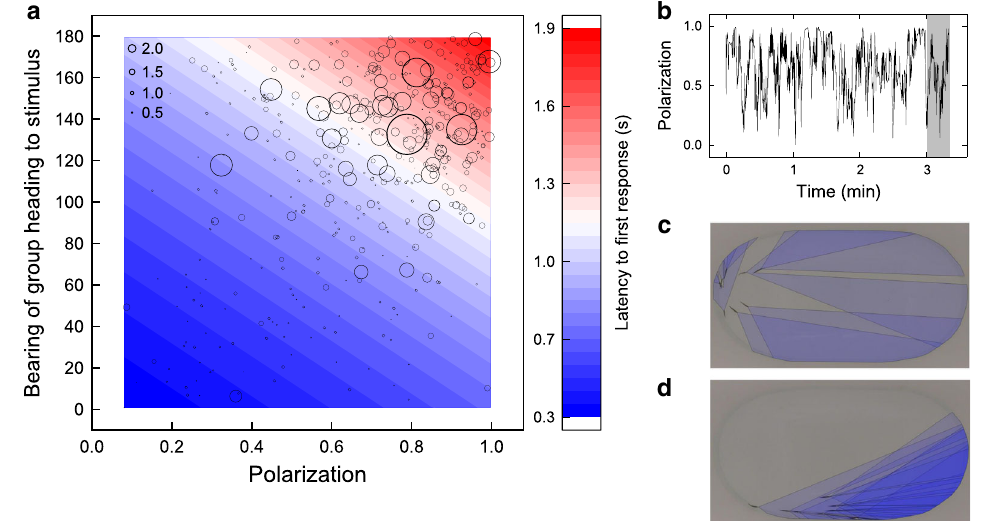
Fig. 2 Variation in collective order affects the latency to fi rst respond to the stimulus. a The effects of group polarization and bearing of the group heading to the stimulus on the latency of fi rst responders to respond to the stimulus. Points represent the raw data with point sizes scaled relative to the latency to respond (seconds, scale bar displayed in the top left-hand corner). The colour gradient (blue to red) represents the predicted response latency (seconds) generated from a negative binomial GLMM with all other group-level parameters held at their mean value. b Example time series of a group ’ s polarization to illustrate temporal variation in collective order. The time series shows the 3 min before (unhighlighted) and 20 s following (highlighted in grey) a single stimulus presentation. c An illustration of the binocular visual range of a disordered group. d An illustration of the binocular visual range of a highly polarized group. In c , d , the blue regions highlight the area of the arena within the binocular visual range of the group, approximated with ray-casting methods (see